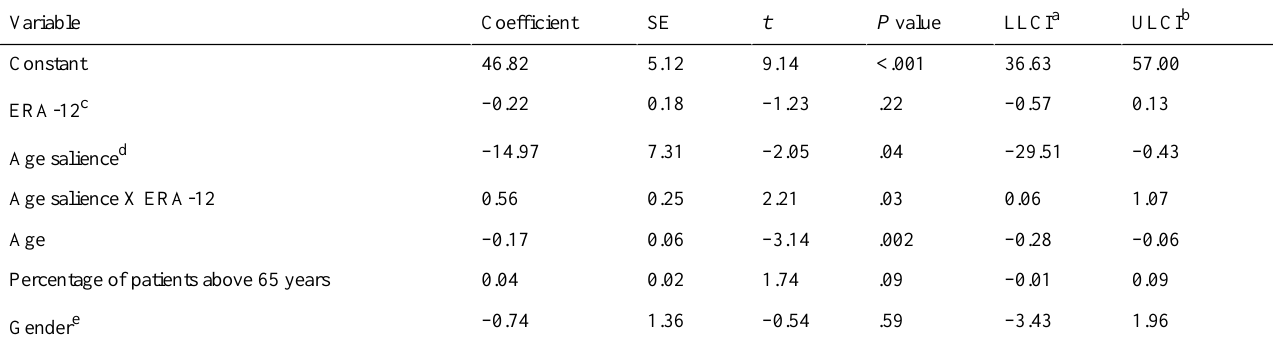
Table 4. Regression coefficients of the moderation model between ERA-12 and attitudes toward older adults using technology (ATOAUT-10) by age salience, with controlling for age, gender, and professionals’percentage of patients above 65 (N=92).